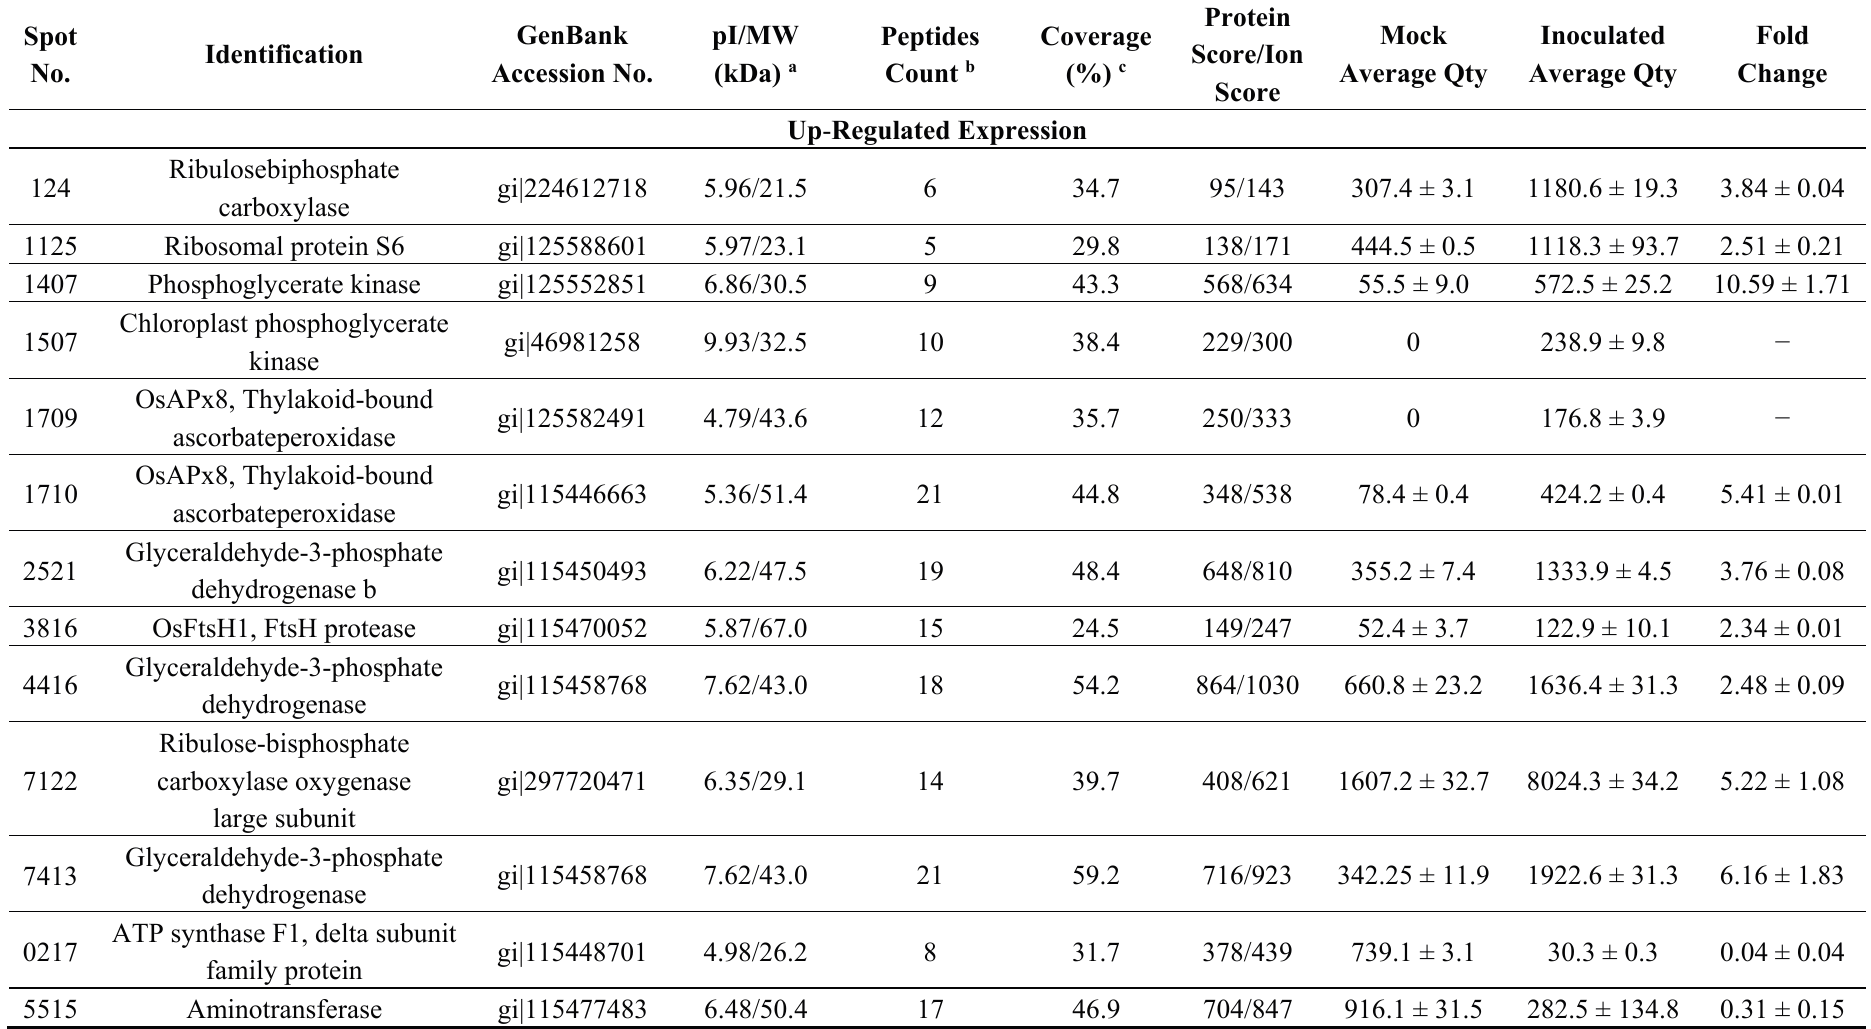
Table 1. Differentially expressed proteins in rice leaves at 24 h post inoculation with Puccinia striiformis f. sp. tritici .